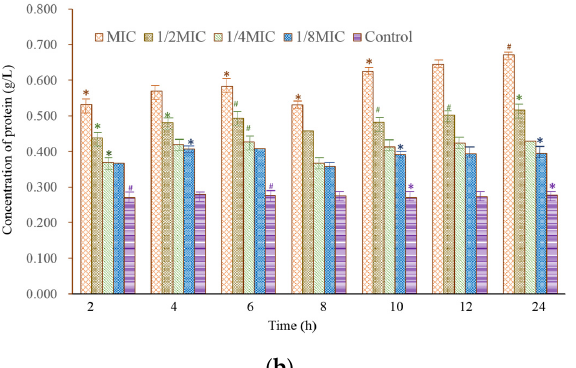
Figure 2. Effects of RTMBE on the bacterial growth ( a ) and extracellular protein concentration ( b ). Cells treated with the same volume of PBS were used as the control. Values are the mean ± SEM of three repeats and significantly different from the control group (* p < 0.05 and # p < 0.01).